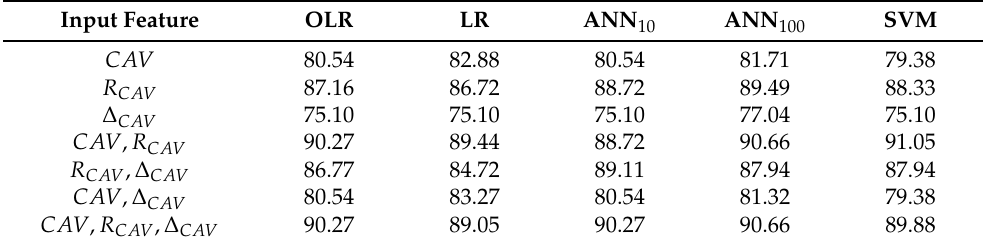
Table 1. Accuracy (%) of ML models for different feature combinations (Set-1: training & test).